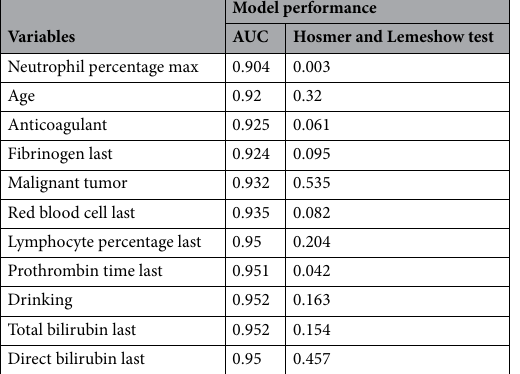
Table 3. Model performance according to variables added. Last: The last test results before the diagnosis of pulmonary embolism. Max: The maximum test results before the diagnosis of pulmonary embolism.